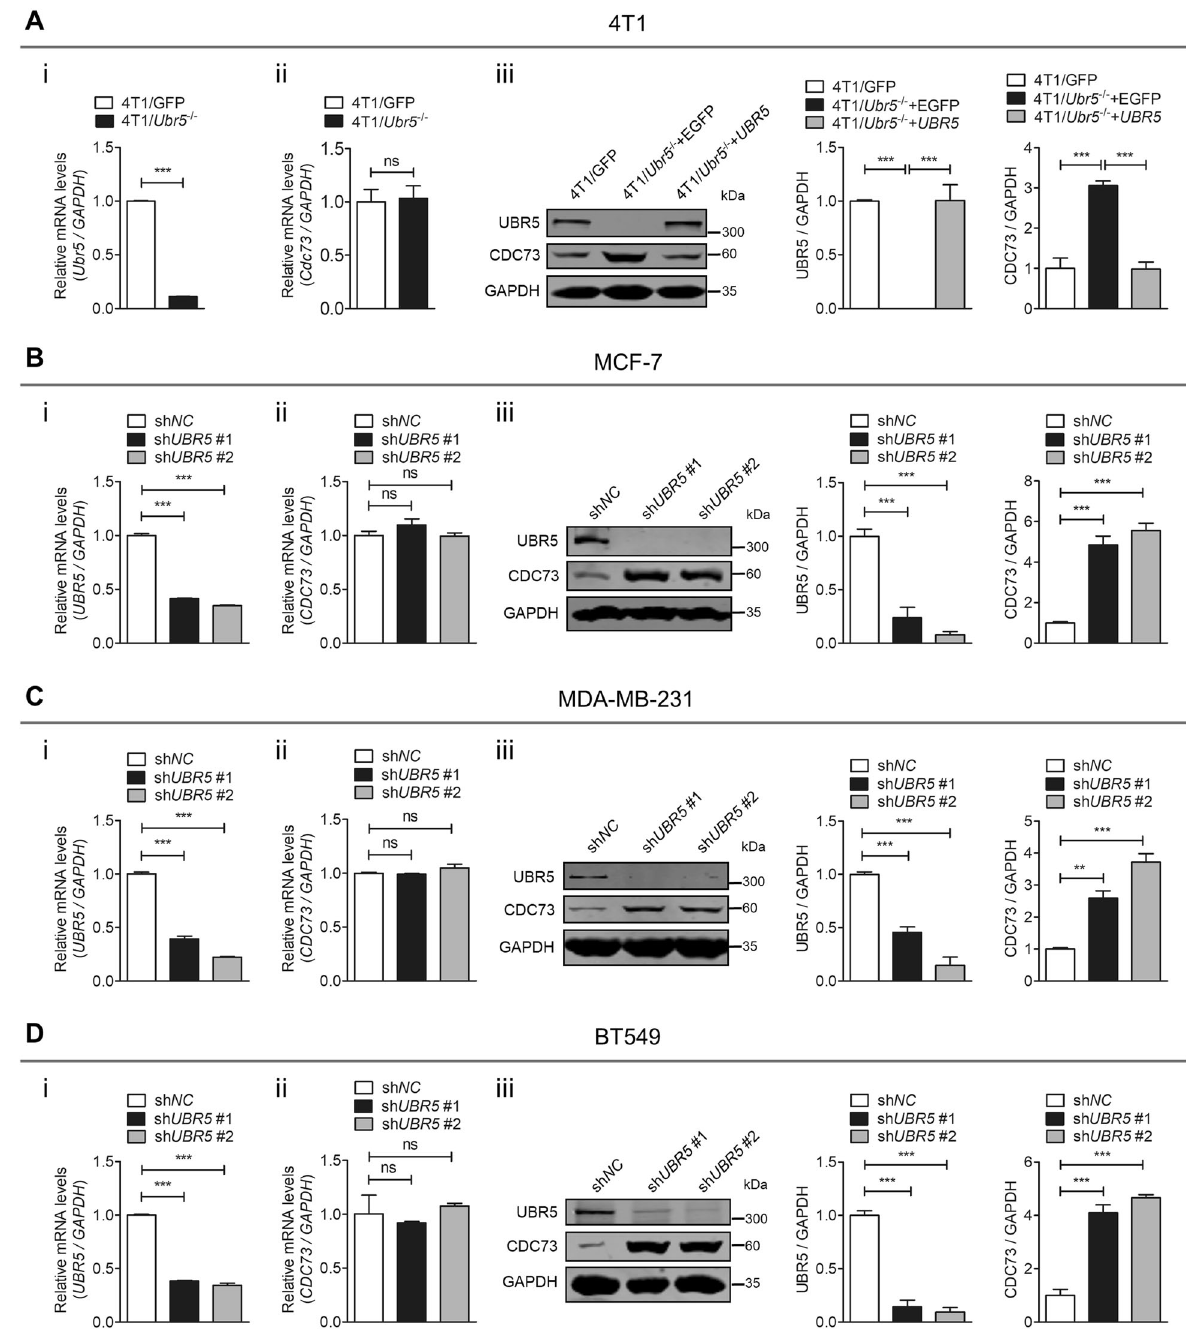
Fig. 2 UBR5 inhibits the protein level of CDC73 in breast cancer cells. A The mRNA expression of Ubr5 (i) and Cdc73 (ii) was measured by qPCR, and their protein level (iii) was analyzed by western blotting in 4T1/GFP and 4T1/ Ubr5 − / − cells. sh NC and UBR5 -knocked down MCF-7 cells ( B ), MDA-MB-231 cells ( C ), and BT549 cells ( D ) were analyzed for the mRNA expression of UBR5 (i) and CDC73 (ii), and their protein level (iii) by qPCR and western blotting, respectively. Data were shown as mean ± SEM for triplicates; ns not signi fi cant; ** p < 0.01; *** p < MG132 or bortezomib (BTZ) respectively did not result in (Fig. 6A), suggesting that CDC73 may be destabilized via UBR5 ’ s elevated accumulation of CDC73 (Figs. 6C and S7A), indicating E3 ubiquitin ligase activity. Moreover, the half-life of CDC73 that CDC73, unlike β -catenin, is not directly degraded by UBR5 protein was greatly extended in the absence of UBR5 in cells through UPS. Moreover, treatment with the autophagy inhibitor treated with the protein synthesis inhibitor cycloheximide chloroquine (CQ) or ba fi lomycin A1 (BafA1) did not increase the (CHX) from 17 h to well above 24 h (Fig. 6B), further supporting level of CDC73 protein either (Fig. S7B, C), ruling out the the notion of the involvement of a protein degradation possibility that CDC73 is degraded by the autophagy-lysosome mechanism. Hence, we next investigated whether the degrada- pathway. Notably, reduction of CDC73 protein was observed tion of CDC73 by UBR5 was through the classic UPS. However, only in the presence of UBR5 with either the broad-spectrum treatment of 4T1/GFP cells with the proteasome inhibitor